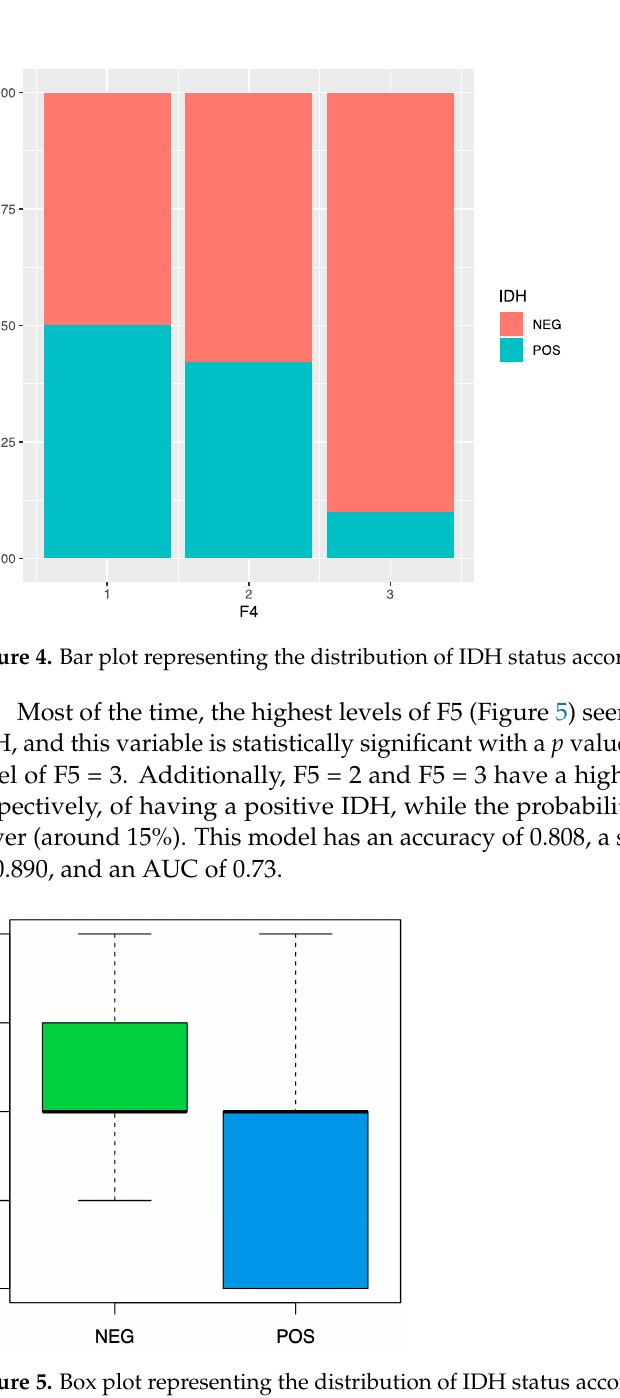
The variable F6 is statistically significant with a p value = 0.000124 < 0.05 and a cut-off Figure 5. Box plot representing the distribution of IDH status according to the F5 VASARI variable. level of F6 = 5. Additionally, F6 = 6 and F6 = 7 have the highest probabilities of 100% and